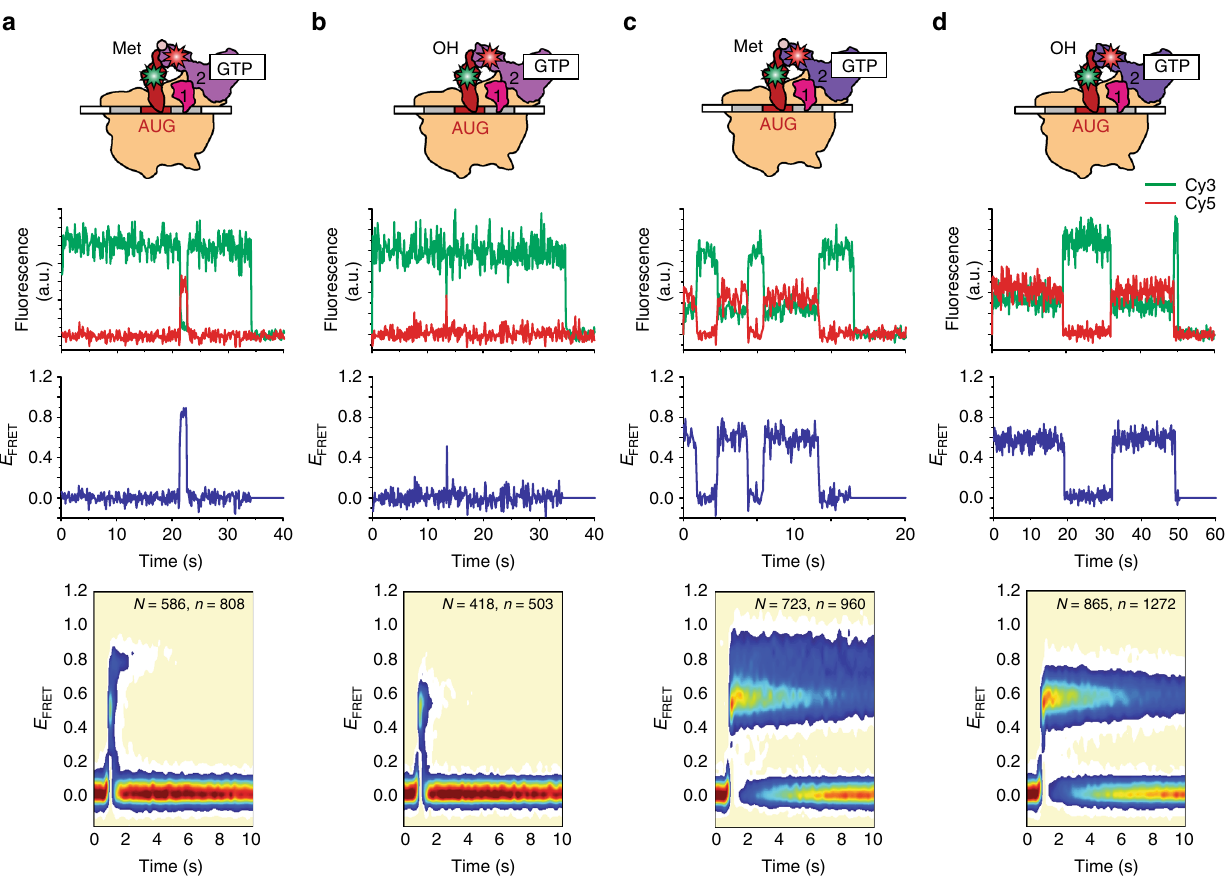
Fig. 3 Effect of substituting fMet-tRNA fMet with Met-tRNA fMet or tRNA fMet . smFRET measurements of ( a , b ) wtIF2(GTP) and ( c , d ) mutIF2(GTP) interacting with ( a , c ) 30S IC wT,Met or 30S IC mT,Met , respectively, and to ( b , d ) 30S IC wT,OH or 30S IC mT,OH , respectively. Data are displayed as in Fig.